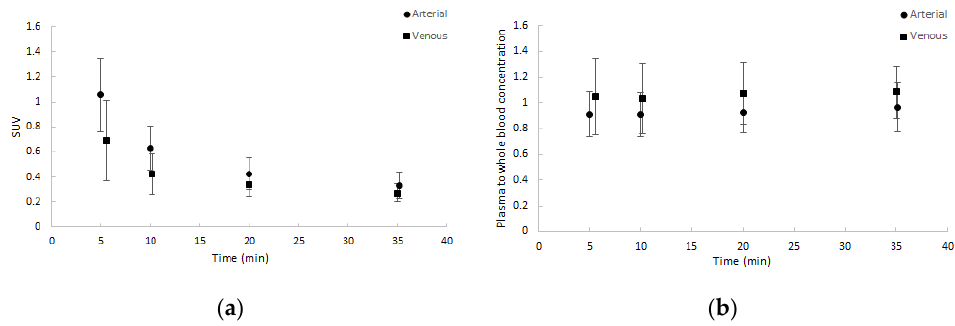
Figure 2. Average blood sample data (dots) with one SD range (error bars) as a function of time (minutes): ( a ) normalised whole blood standardized uptake value (SUV) and ( b ) plasma to whole blood concentration ratios. Both arterial and venous samples are shown.